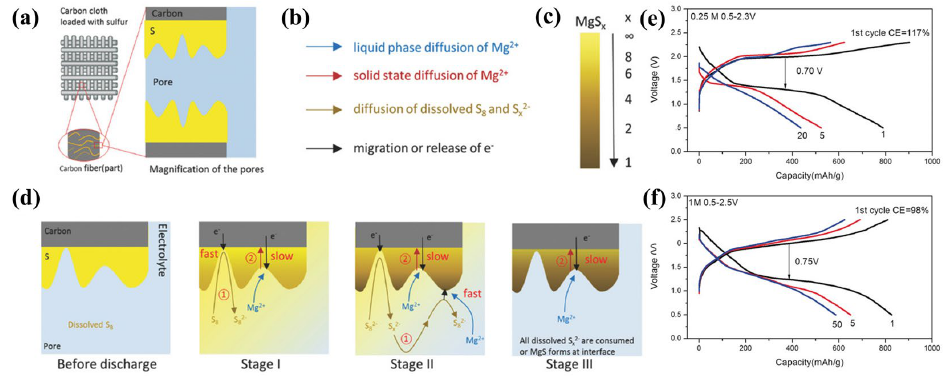
Figure 6. ( a ) Structure of the S/ACC composite cathode. ( b – d ) The proposed sulfur reduction mechanism. 1 (cid:13) Surface magnesiation. 2 (cid:13) Bulk magnesition. [18]. ( e ) The S/ACC electrochemical